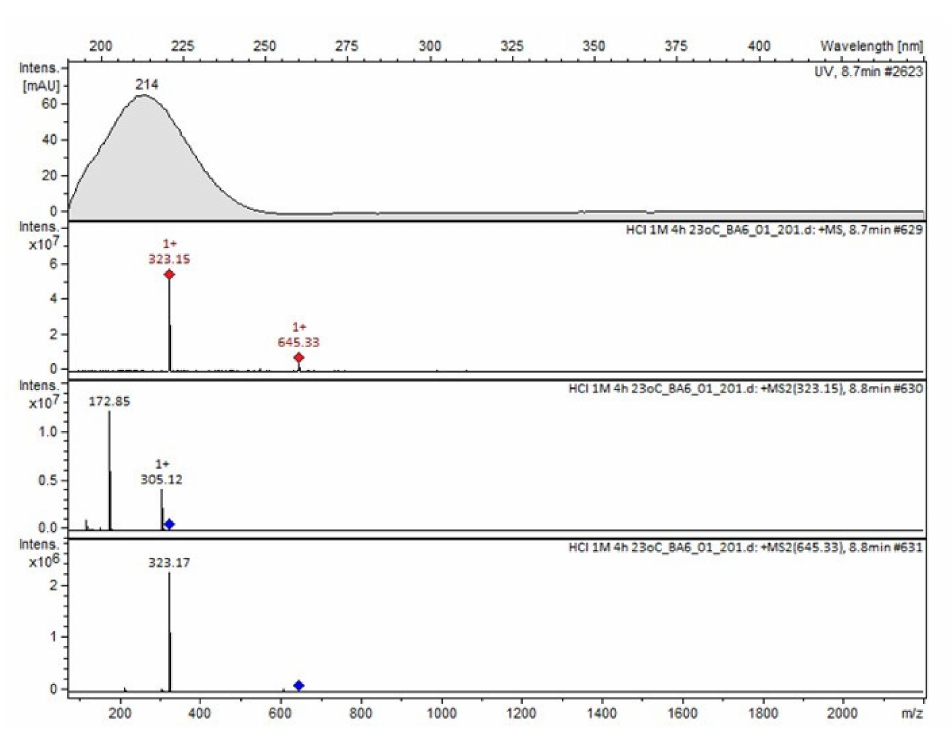
Figure 7. MS and UV/VIS spectra of Compound B.